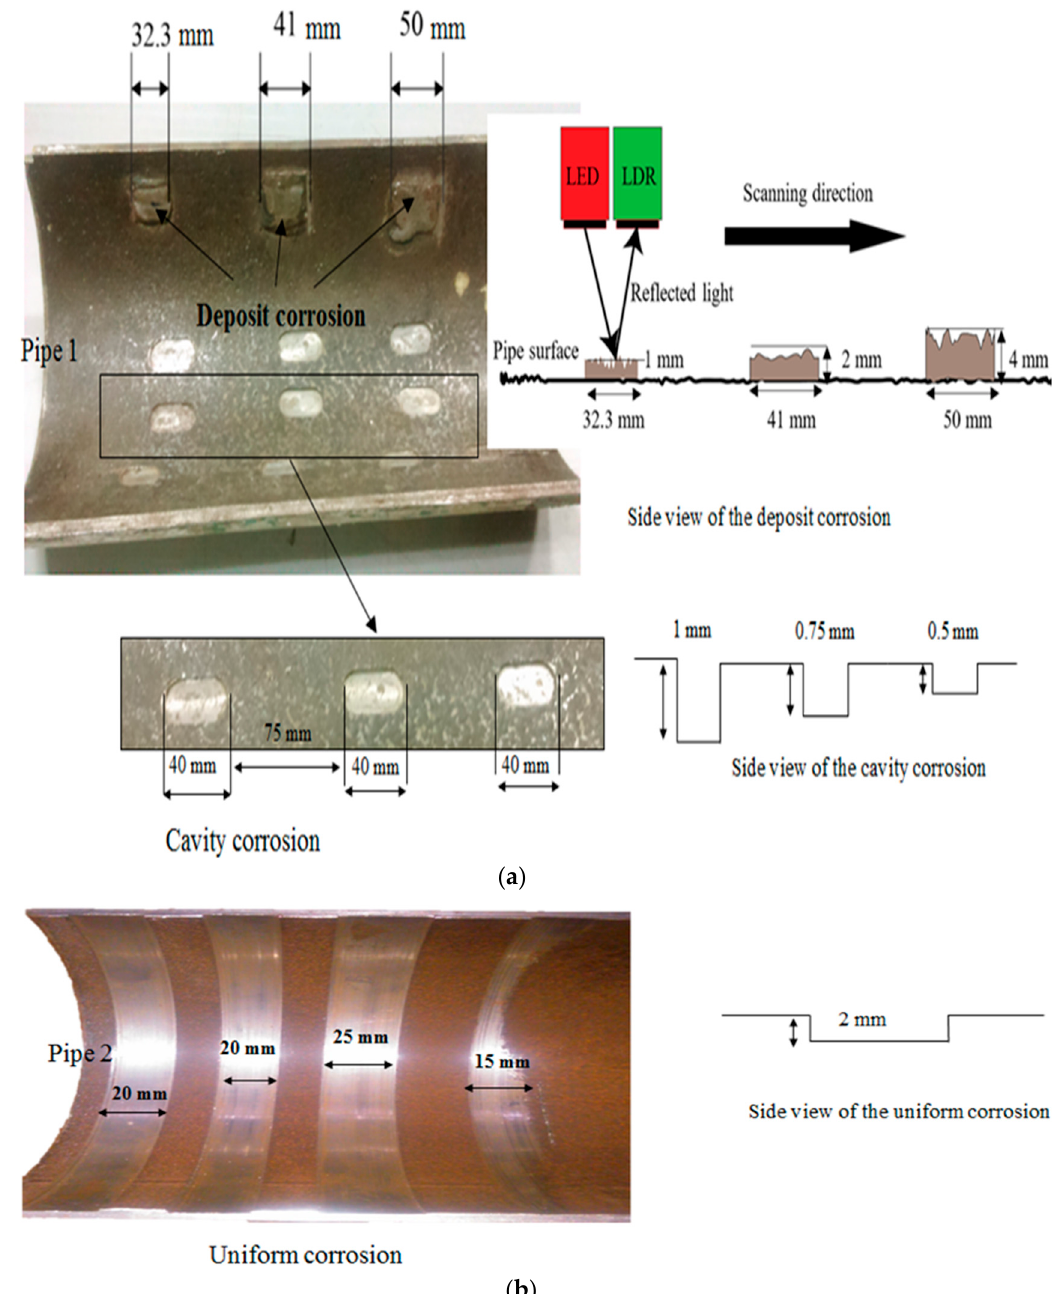
Figure 3. The specimens for the experimental studies with dimensions and three different types of corrosion. ( a ) deposit and cavity corrosions, ( b ) uniform corrosion Table 2. Chemical composition of the steel pipeline in